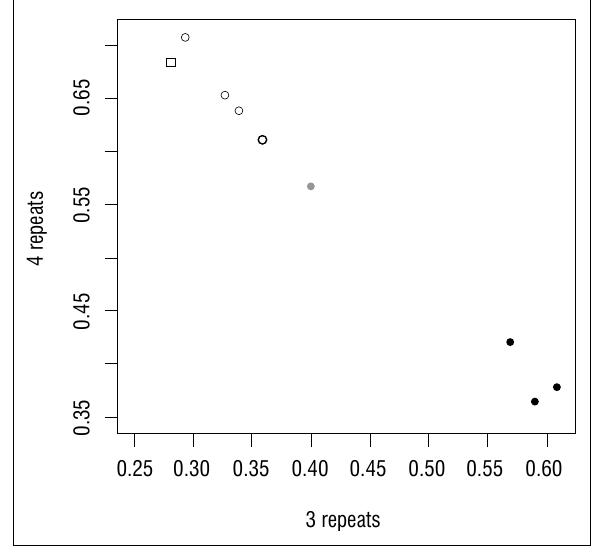
Figure 2: The frequencies of the two common MAOA alleles for the 10 populations included in Table 1. Open symbols indicate the six populations of a mostly European background that are not significantly different from one another and the filled symbols indicate the Asian and African populations. The grey circle represents the Italian population which differs significantly from the Afrikaner population (indicated by the square symbol), but not from the African American